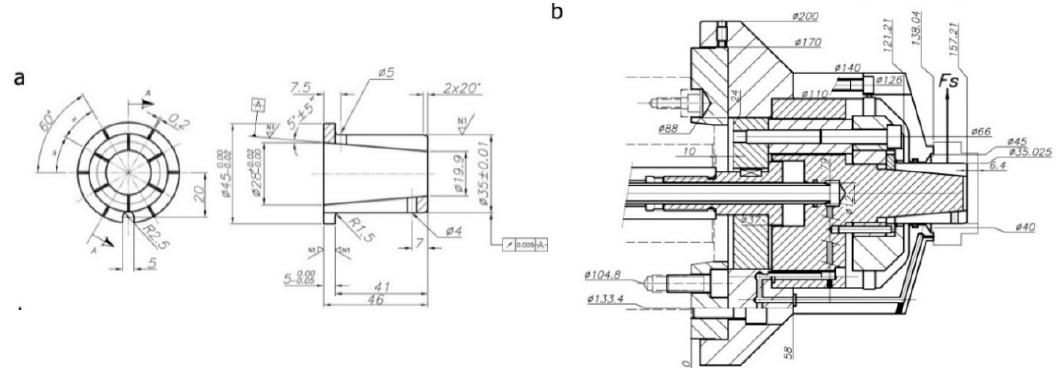
Figure 15. Special expanding mandrel dimensions: ( a ) collet, ( b ) acting system.